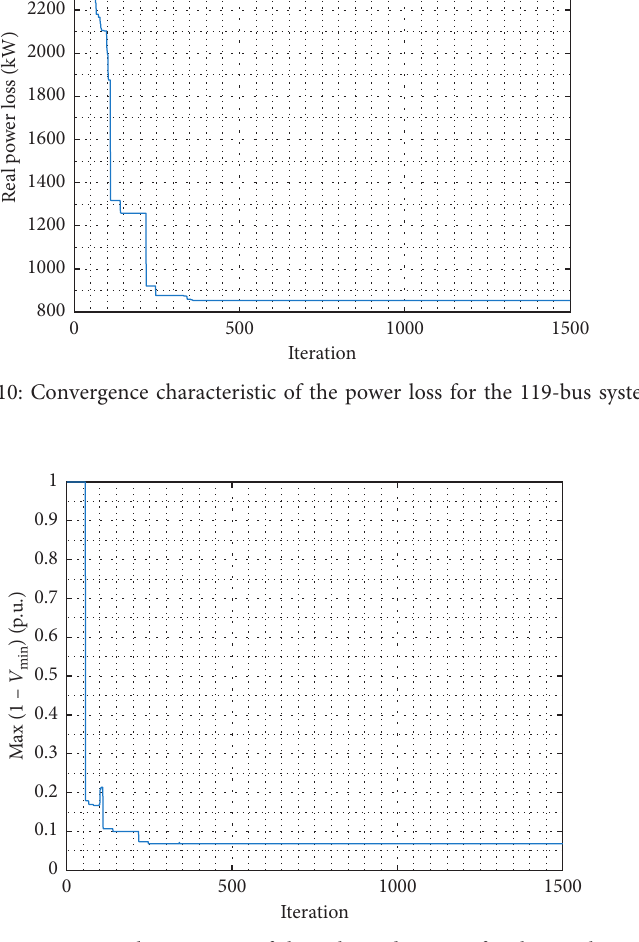
Figure 11: Convergence characteristic of the voltage deviation for the 119-bus